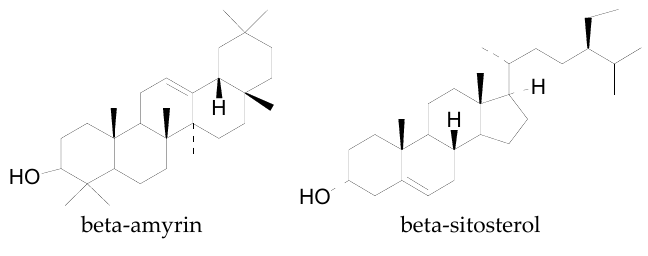
Figure 8. Triterpene derivatives in cotton.